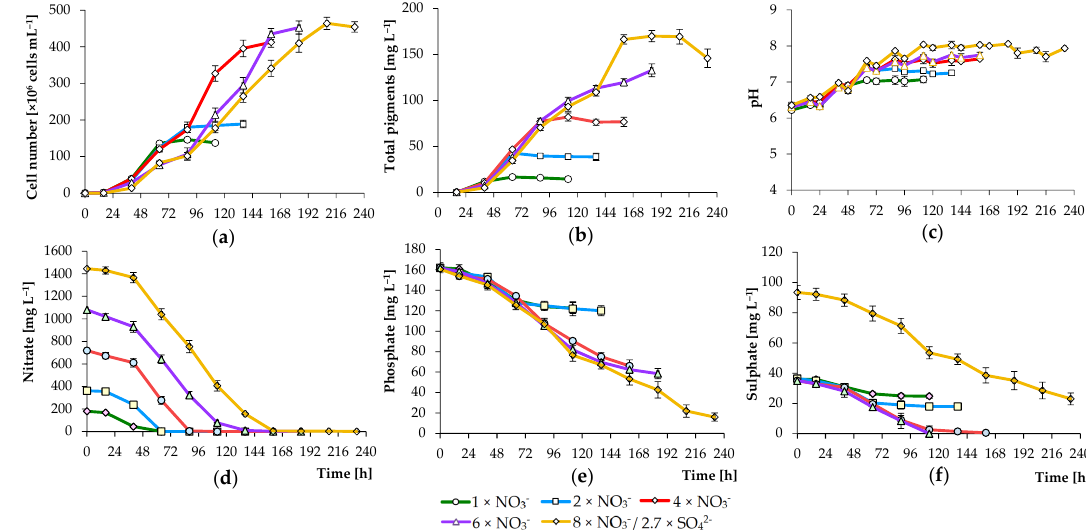
Figure 5. Growth of C. sorokiniana AM-02 ( a ), total pigment concentration in cells ( b ), culture medium pH ( c ), as well as nitrate ( d ), phosphate ( e ), and sulfate ( f ) removal from the medium in di ff erent treatments with modified BBM (PPFD and CO 2 concentration values: 1200 µ mol photons m − 2 s − 1 and 2.0% CO 2 ,